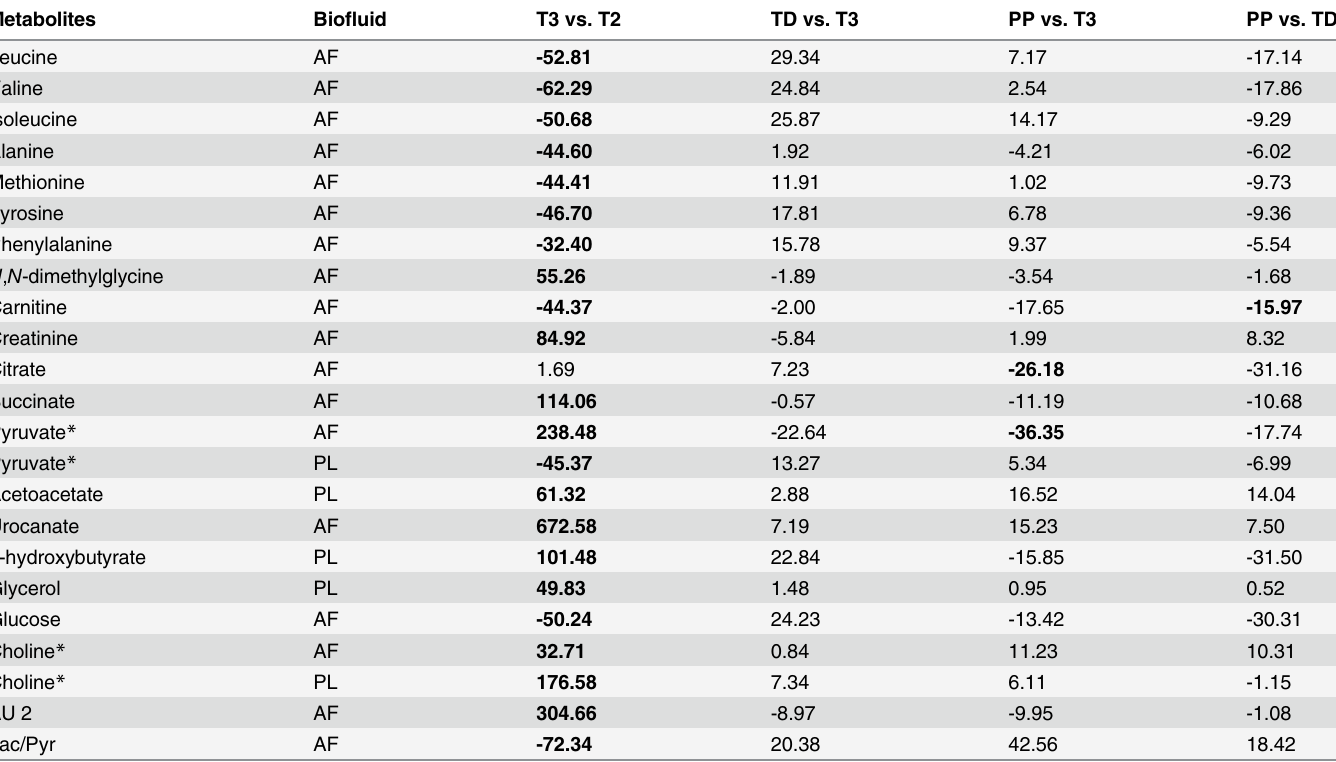
Table 2. Differences of metabolites (expressed as percentage) between the four gestational age periods.